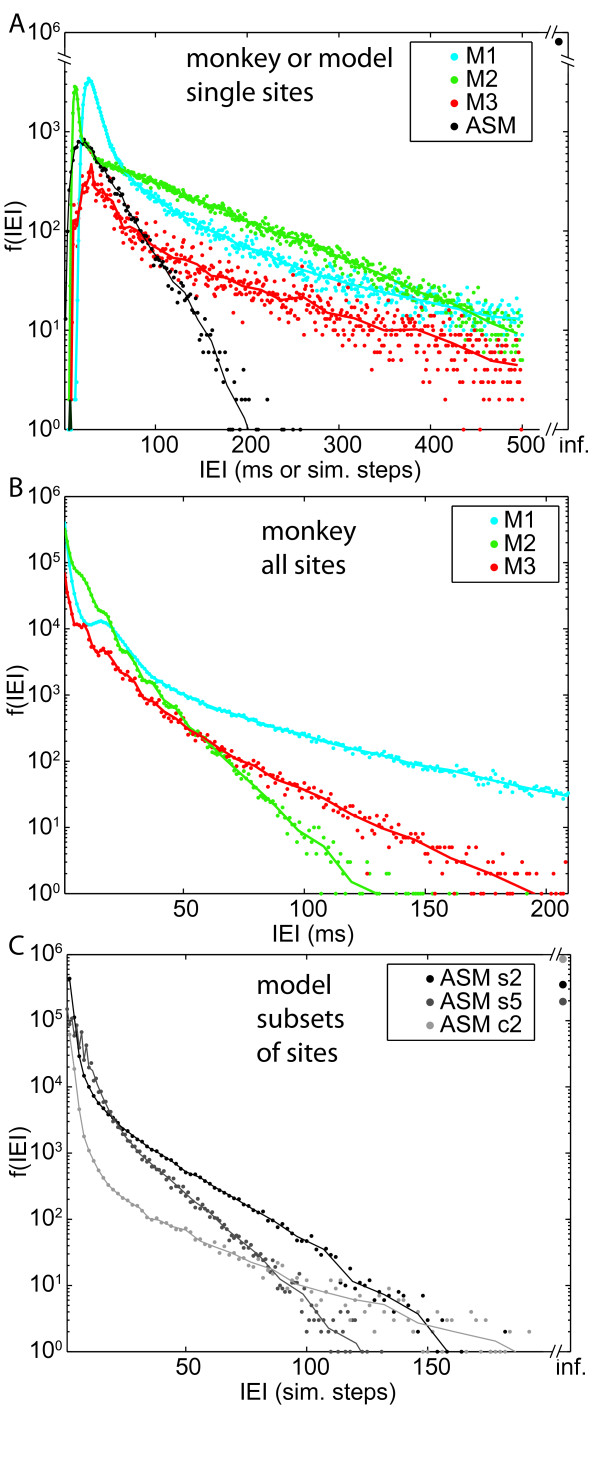
Distribution of inter event intervals (IEIs). (A) IEIs evaluated for data obtained from a single site in M1 (olive), M2 (dark green), M3 (light green), and of the ASM (black). (B) IEIs evaluated for the data obtained from all electrodes in M1 (olive), M2 (dark green), and M3 (light green). (C) IEIs evaluated for data obtained by subsampling the ASM on s2 (black), s5 (dark grey), and c2 (light grey).